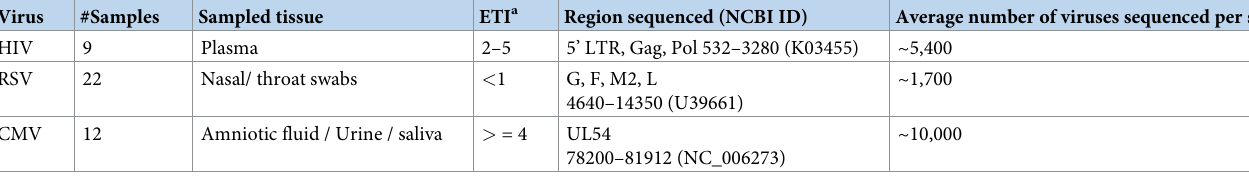
Table 1. Details of samples sequenced from clinical virus